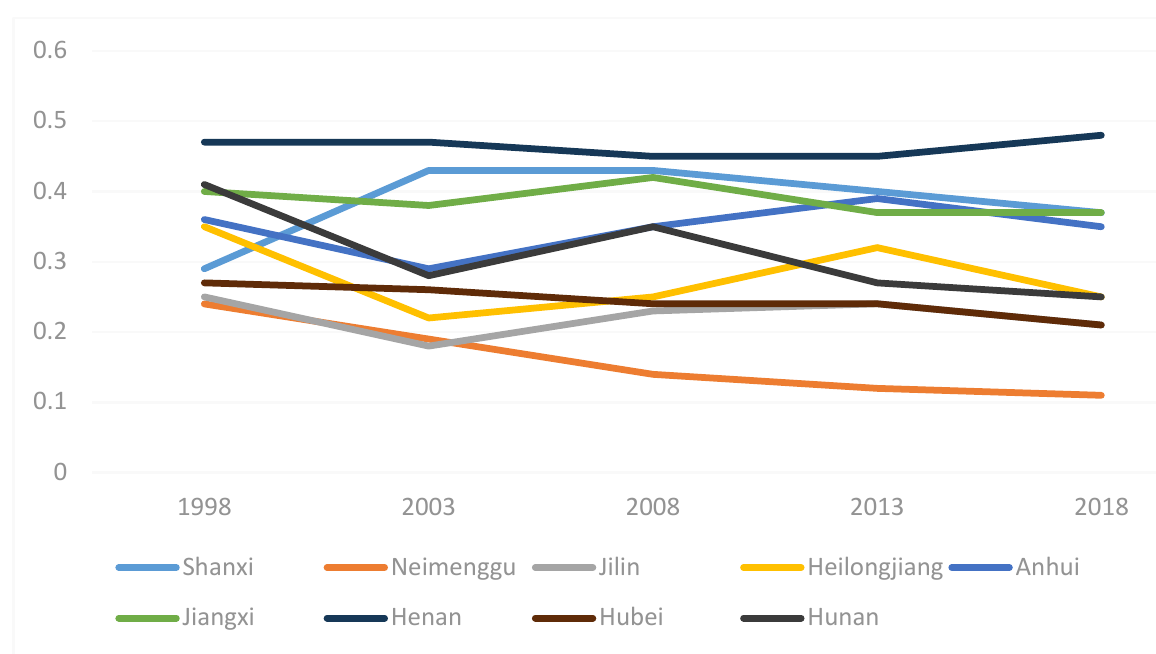
Figure 3. Productivity in Western Provinces during 1998 – 2018. 3.2. Spatial Distribution of Swine Production Efficiency in Provinces and Cities The hog production efficiency values of 30 provinces and cities in China were classi- fied into different levels using ArcGIS software. The figure 4 below shows that there are more obvious regional differences in swine production efficiency in different regions in 30 provinces and cities across the country. These five graphs show that the nation’s overall swine farming production efficiency remained consistent and did not undergo significant swings in 1998, 2003, 2008, 2013, and 2018. However, in terms of spatial distribution, there is an obvious spatial agglomeration phenomenon in the hog-breeding industry. Although the production efficiency of hog breeding varies in different provinces and cities, from the perspective of spatial distribution, the production efficiency of hog breeding is generally high in the south and low in the north. The southern provinces, such as Guangdong, Hai- nan, Jiangxi, Anhui, Hunan, and Zhejiang, generally rank in the middle to upper levels, although swine breeding production efficiency varies. Similar to Shanxi, Henan, and Shandong, the production efficiency of grain-producing provinces generally rank in the middle to upper level. Although the production efficiency of northern provinces, such as